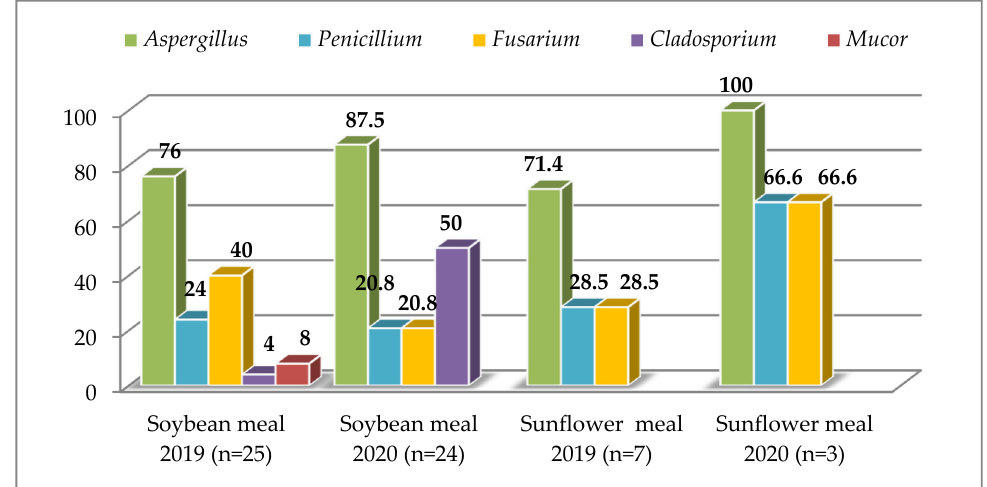
Figure 2. Proportion (%) of potentially toxigenic fungal genera in positive soybean and sunflower meal samples (n—number of positive samples).